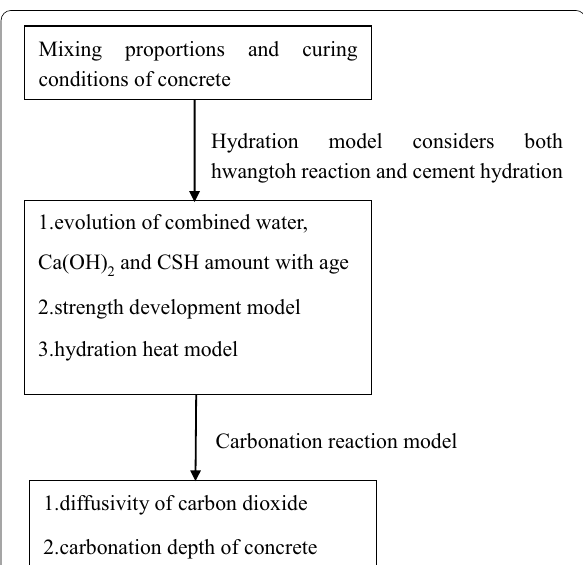
Fig. 1 Simulation framework of hwangtoh‑blended